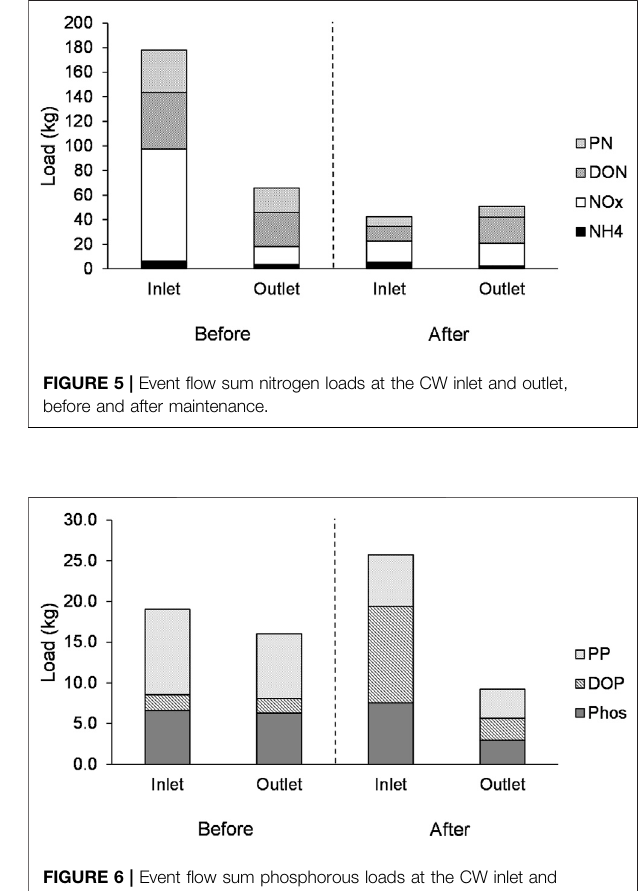
FIGURE 6 | Event fl ow sum phosphorous loads at the CW inlet and outlet, before and after